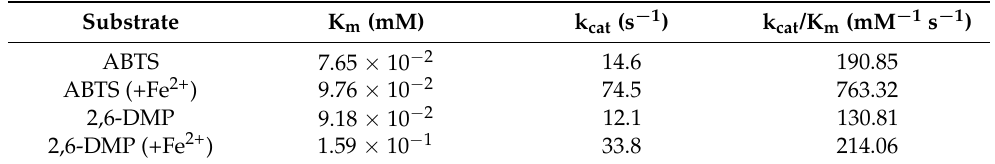
Table 1. Kinetic parameters for Melac13220 obtained with ABTS and 2,6-DMP as reaction substrate before and after addition of Fe 2+ .